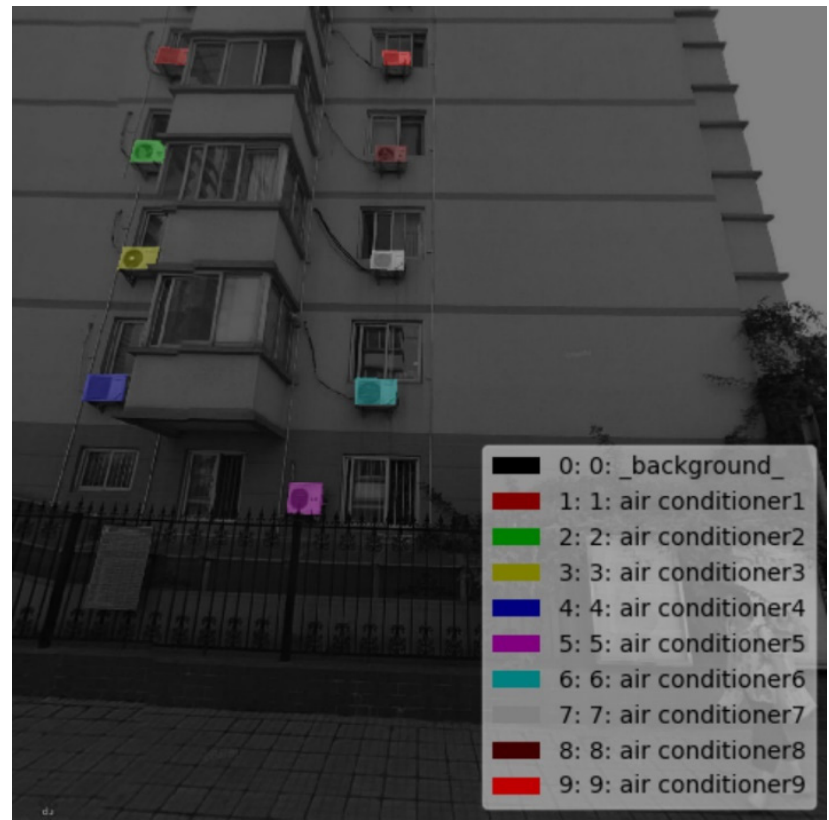
Figure 2. An example of the labeled images with Labelme. The background is covered with a black mask. Each target entity is covered with masks in different colors.